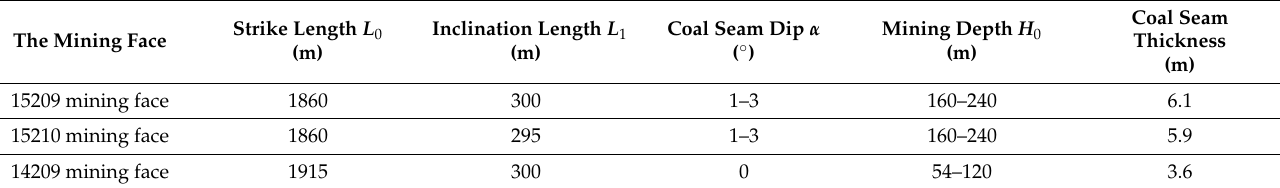
Table 1. Basic parameters of the mining